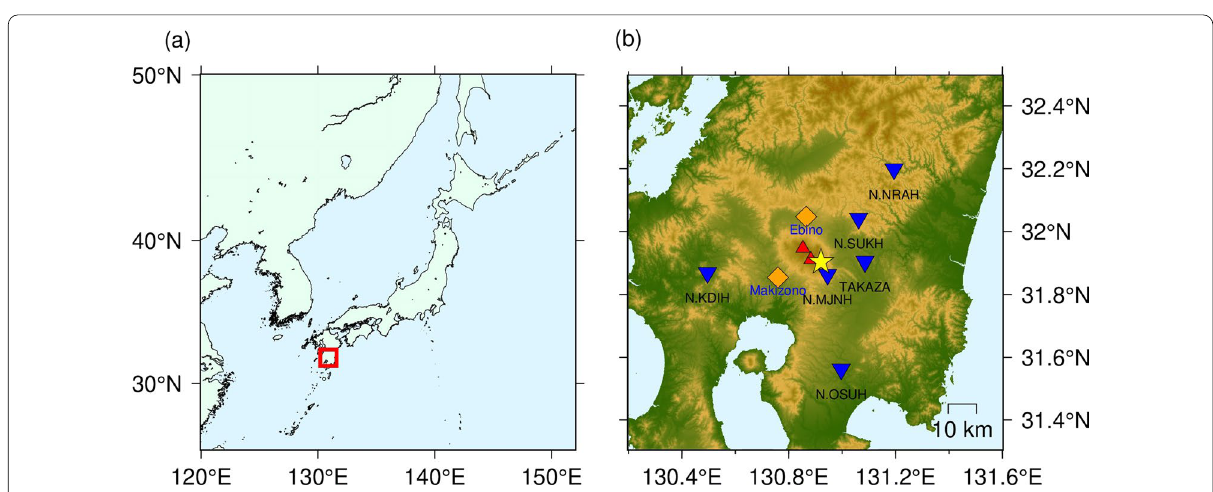
Fig. 1 Map of the Kirishima volcanic complex. a Location of Kirishima volcano in Japan. b Large view of the Kirishima volcanic complex corresponding to the red rectangle in figure (a). The red triangles indicate the Shinmoe-dake (East) and Io-yama (west). The yellow star marks the primary location of the DLF earthquakes. Blue inverted triangles are seismic stations operated by the National Research Institute for Earth Science and Disaster Resilience (NIED) and Japan Meteorological Agency (JMA), and orange diamonds are the locations of the Ebino and Makizono global navigation satellite system (GNSS) stations, which are operated by the Geospatial Information Authority of Japan (Sagiya